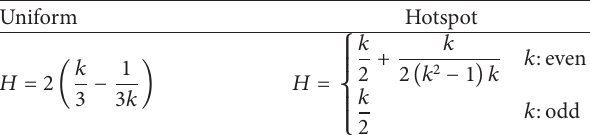
Table 1: Calculation of Hop Count in 𝑘 -ary-2-mesh. Uniform Hotspot